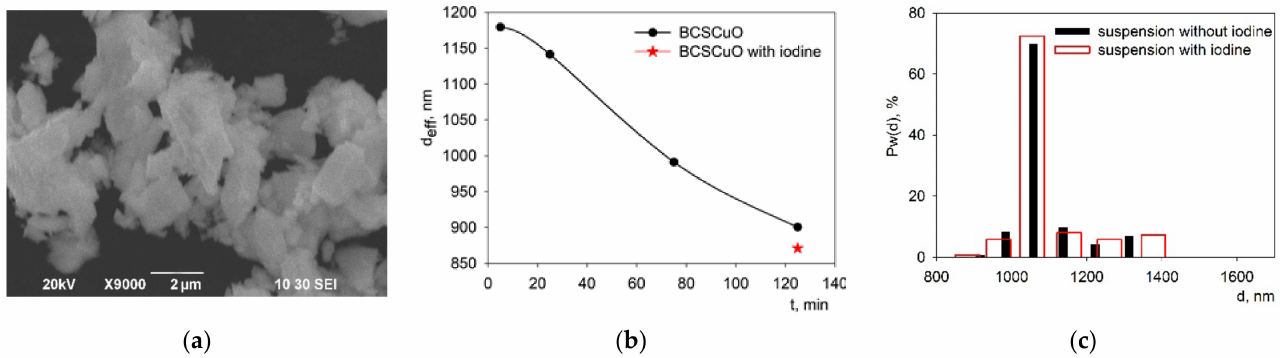
Figure 3. ( a ) Morphology of the initial BCSCuO powder for the suspension preparation; ( b ) Depen- dence of the effective hydrodynamic diameter of aggregates, d eff , on the UST time; ( c ) Fractional composition of the BCSCuO suspension with/without